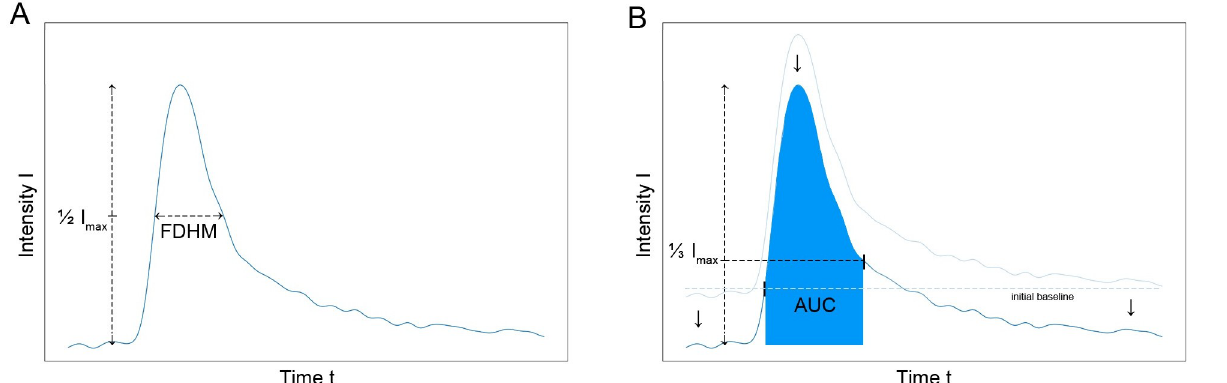
Fig 3. Algorithms for velocity calculation. (A) FDHM method: The FDHM is the time span at which at least half of the maximum intensity is present. The mean velocity can then be calculated by including the size of the FOV in longitudinal direction. (B) Tracer dilution method: The flow rate can be calculated by dividing a calibration constant by the area under the curve (AUC) of the signal intensity over time curve. The first border of the AUC is the intersection of the mean intensity of the initial baseline and the baseline subtracted intensity over time curve. The end of the AUC is defined as the frame at which 33% of the maximum signal intensity is present during signal decline after the peak. The computed flow rate can then by converted to the mean velocity by including the inner diameter of the phantoms.